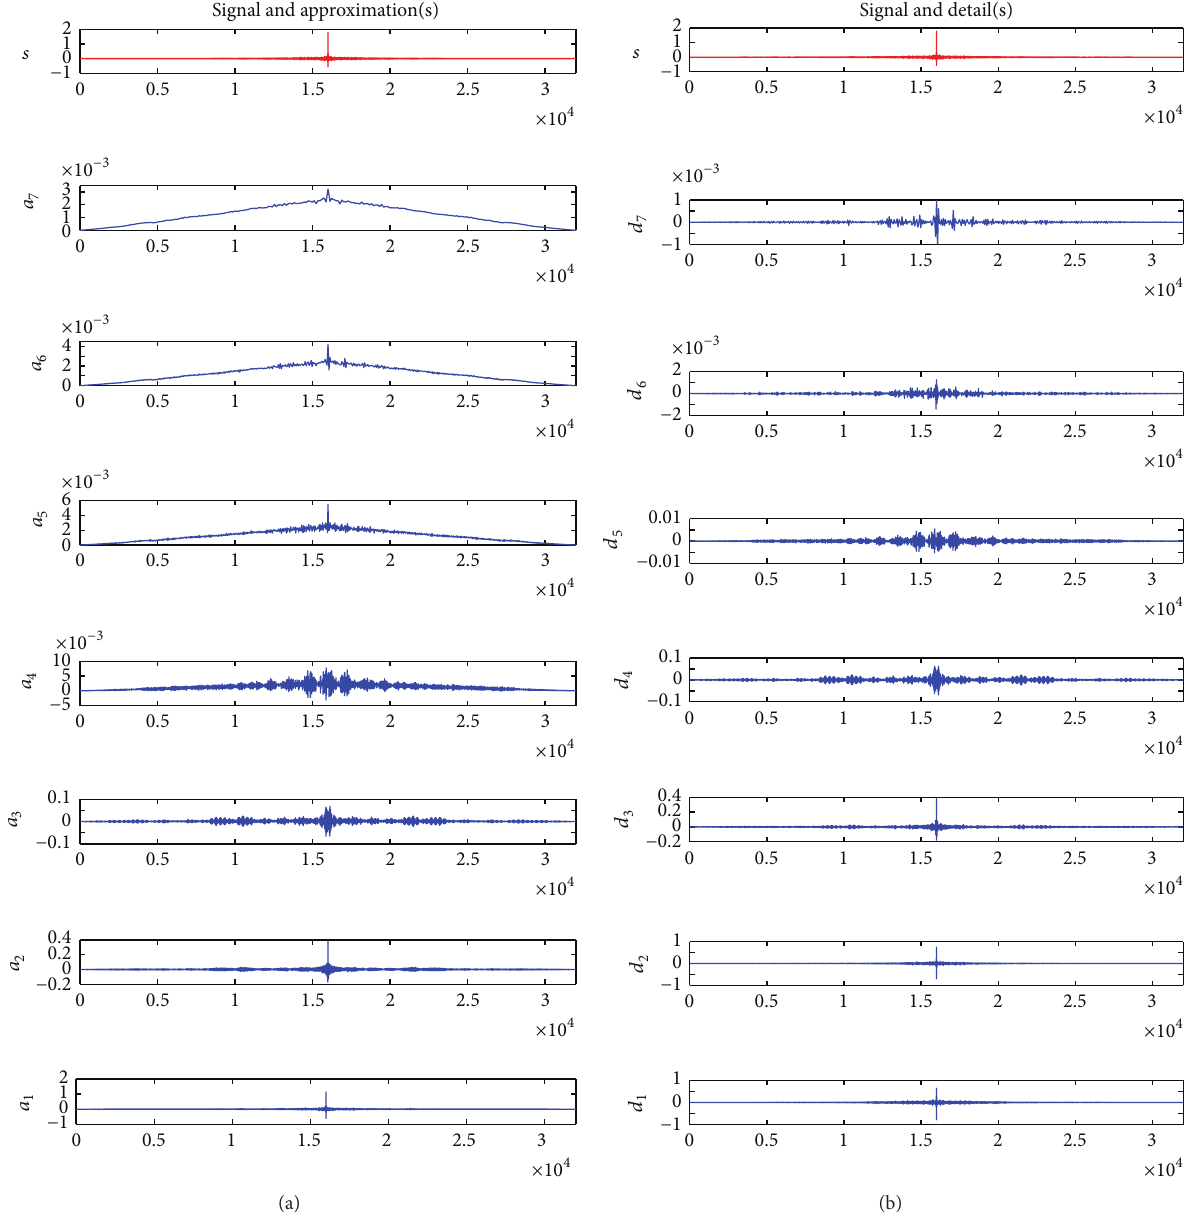
Figure 4: Autocorrelation and DWT decomposition for a motor with one broken bar, (a) approximation, and (b)